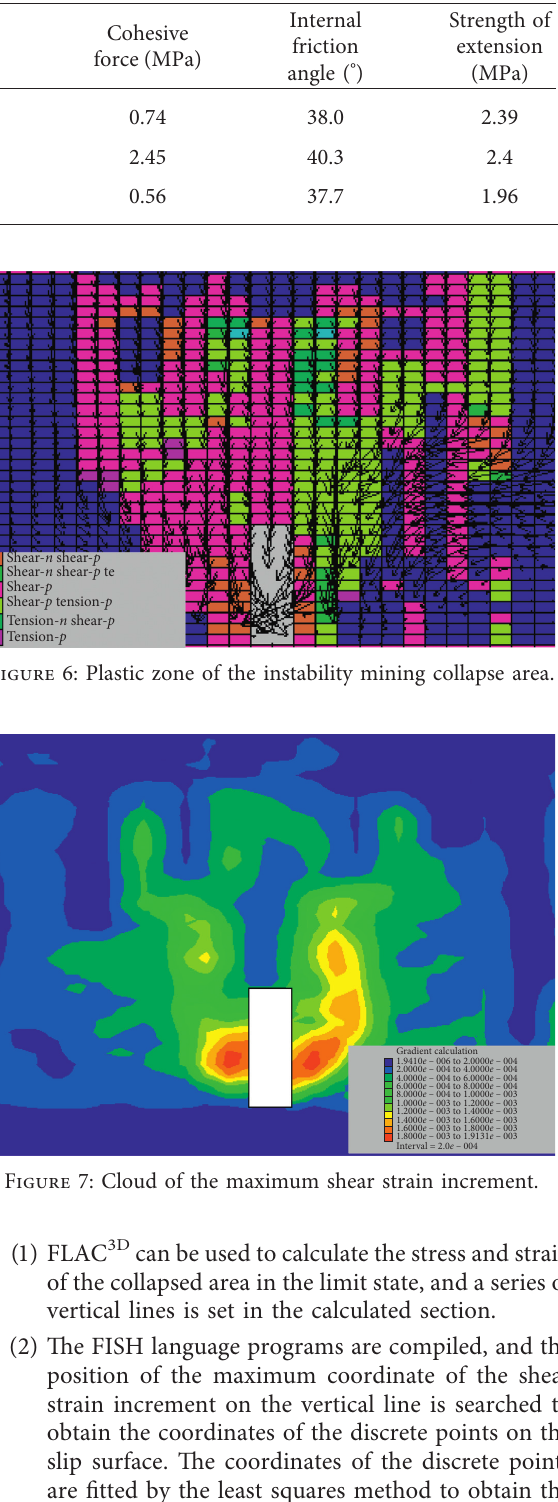
Table 1: Rock mass mechanical parameters.